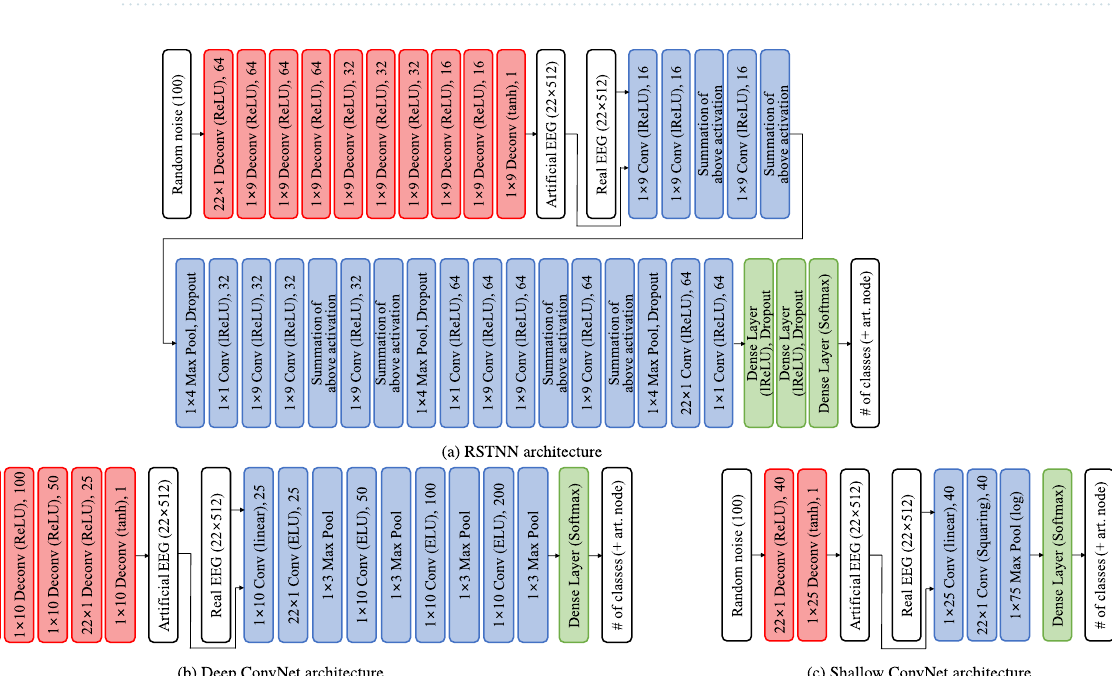
Figure 3. Illustration of three different GAN architectures used in our experiments. In all feature extractors (blue square) F , every convolutional layer was activated by leaky ReLU (lReLU), and the corresponding classifiers (green square) C were activated by tanh . In these combined feature extractors and classifiers, real input EEG and artificially generated EEG that have a matrix form of 22 × 512 were inputted and predictions of networks were outputted (artf. node denotes a node for artificially generated EEG). Meanwhile, in all generators (red square) G , every deconvolutional layer was activated by ReLU with the except of the final layer activated by tanh . In these generators, a random noise vector z ∈ R 100 was inputted, and an artificially generated EEG (22 × 512) was